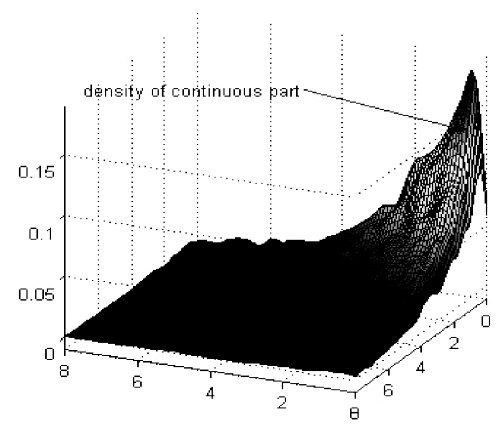
Figure 2 – The density estimate ˆ( , ) f x y